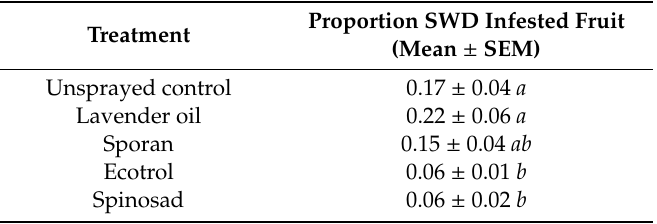
Table 3. Treatment e ffi cacy on the proportion of Drosophila suzukii infested fruit in a semi-field bioassay of primocane raspberries. Store-bought fruit was sprayed in the field and left for 24 h before incubating at 24 degrees Celsius for 7 days to determine the proportion of infested fruit per treatment. Letters denote significance at α =